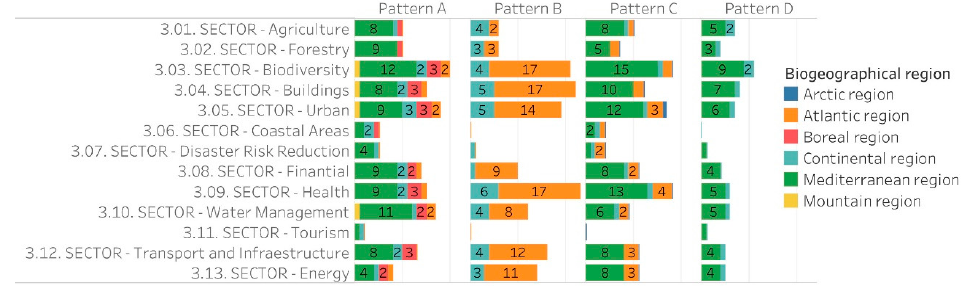
Figure 7. Distribution of initiatives according to Climate Impacts in the different biogeographical regions for each of the patterns. Source: Compiled by the authors.